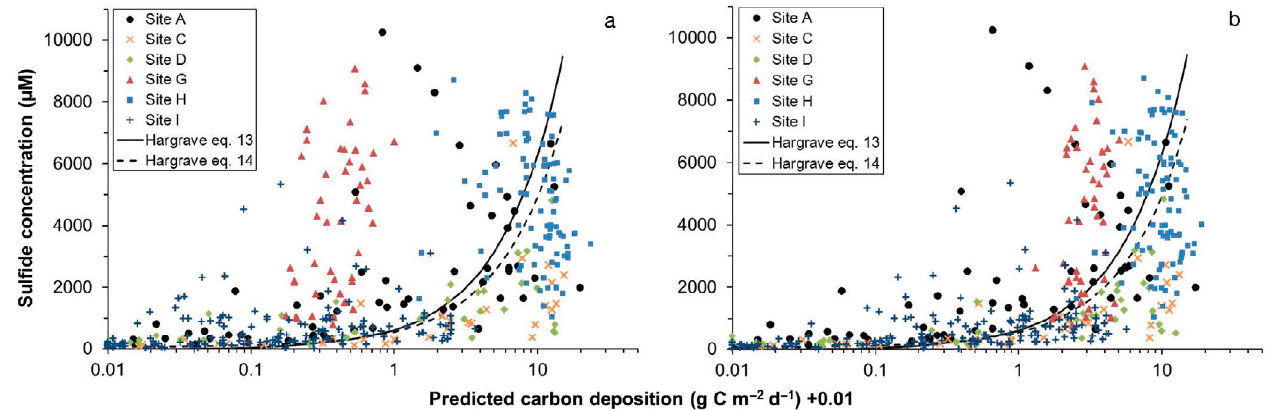
Fig. 8. Relationship between DEPOMOD-predicted carbon deposition rates (without resuspension) and observed sediment sulfide concentrations at 6 salmon farms in southwestern New Brunswick. DEPOMOD was run using average daily feeding rates during (a) 1 mo and (b) 3 mo periods ending near the date of sediment sampling. Deposition rates are for the DEPOMOD grid cell corresponding with each sediment sampling station and are averages of DEPOMOD runs using 2 to 3 current-velocity datasets per site. Sites G and H did not include any sampling stations outside the cage array. Lines represent equations for the rela tionship between these variables from Hargrave (2010)